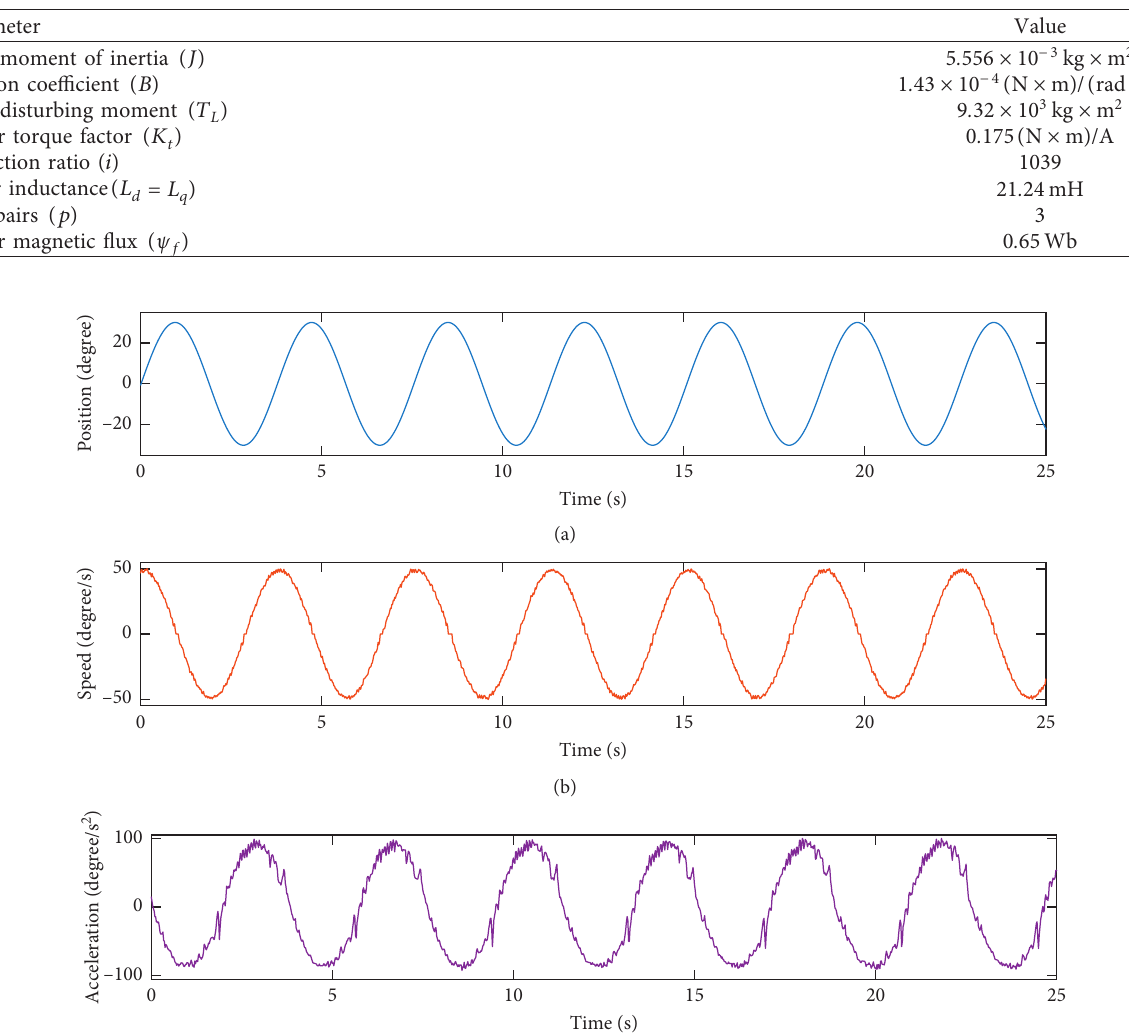
Figure 11: Semiphysical platform structure. Table 2: Parameters in PMSM.